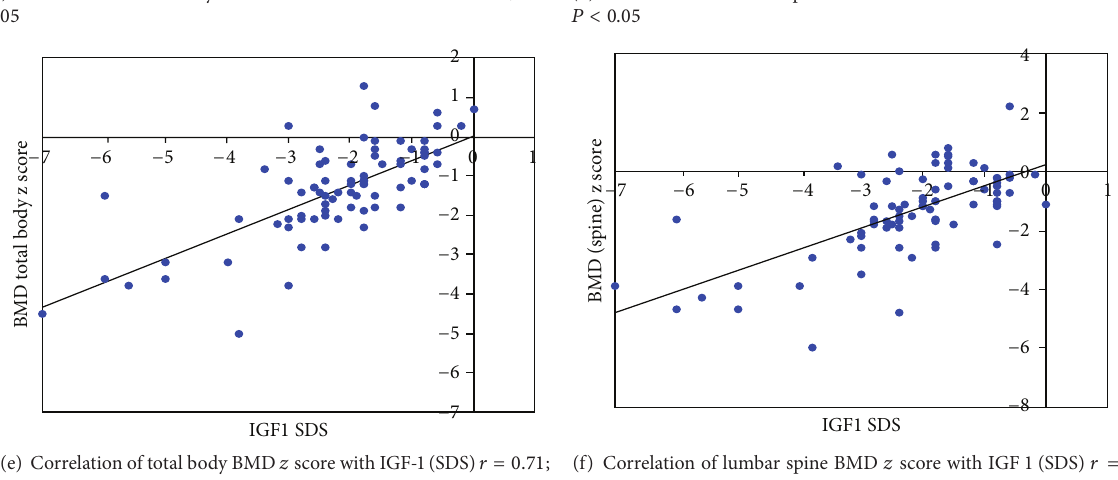
(c) Correlation of total body BMD 𝑧 score with HbA1C 𝑟 = −0.75 ; 𝑃 < 0.05